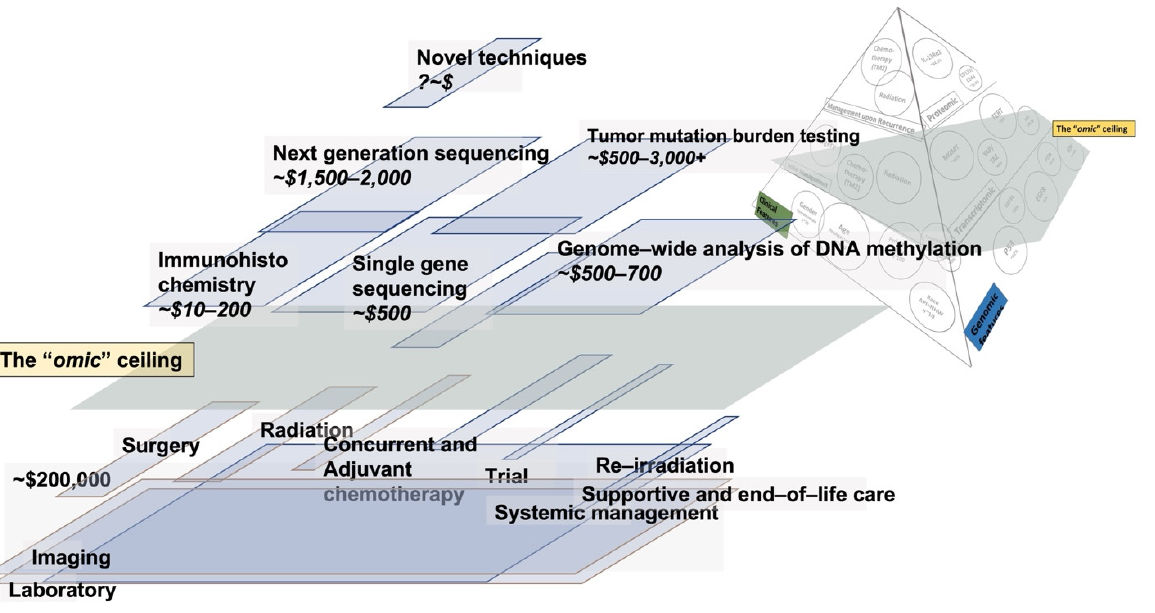
Figure 3. The cost of care and omics in glioma and emergence of the omic ceiling [74–76,78,82,84–